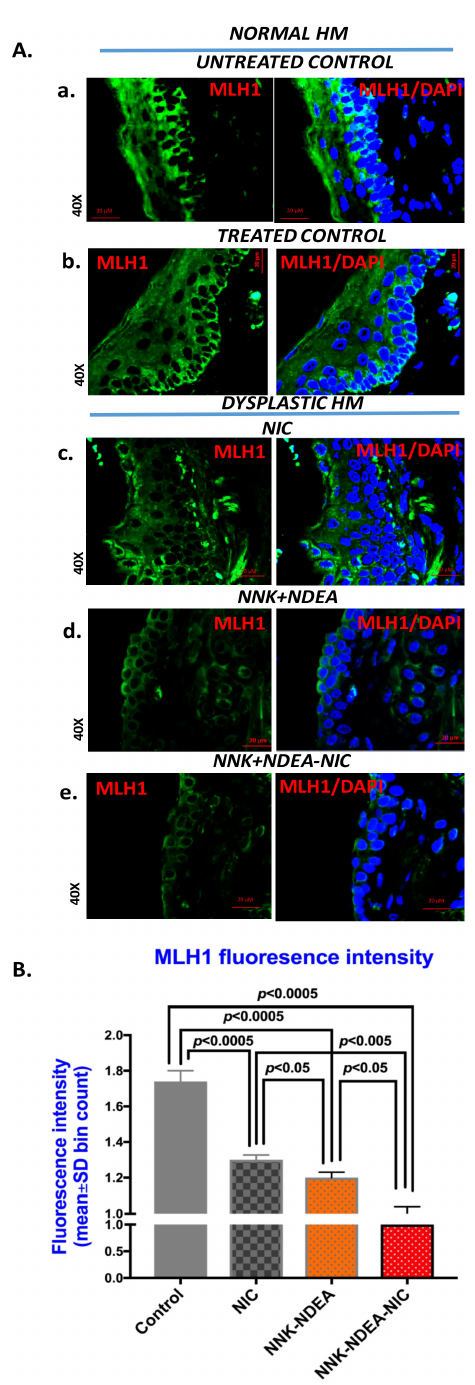
Figure 2. Chronic exposure to TS components decreases MLH1 protein levels in dysplastic murine HM. ( A ). Immunofluorescence staining for MLH1 (DyLight ® 488 for green; blue: DAPI for nuclear DNA staining; scale bar 20 µ m by Zen imagining software). ( a ) Untreated control, ( b ) Treated control (normal HM): intense cytoplasmic staining in basal/parabasal cells, ( c ) NIC-treated HM (mild dysplastic), ( d ) NNK-NDEA-treated HM (moderate dysplastic), ( e ) NNK-NDEA-NIC-treated HM (severe dysplastic) (original magnification 40x). ( B ). Graphs created by GraphPad Prism 7.0, demonstrate statistically significant differences of scores (mean ± SD) for MLH1 staining between TS components treated HM vs. controls ( p < 0.05 by t test; multiple comparisons by Holm-Sidak; GraphPad Prism 7.0). (Scores of fluorescence intensity were derived from two independent images (>10 cells per image) from each section (at least two tissue sections per group), using Zen imaging